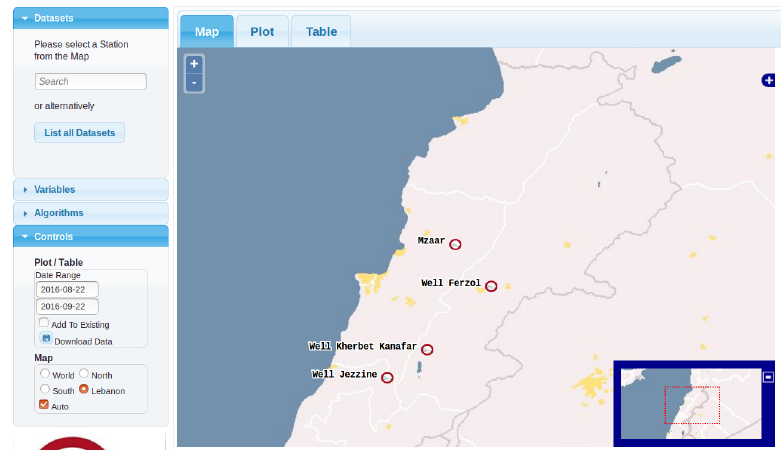
Figure 19. Map showing the location of the snow and wells’ water level measurement stations.